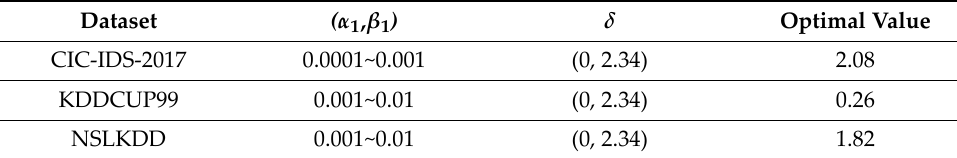
Table 4. Optimal Values of A and B Parameters for Three Datasets.